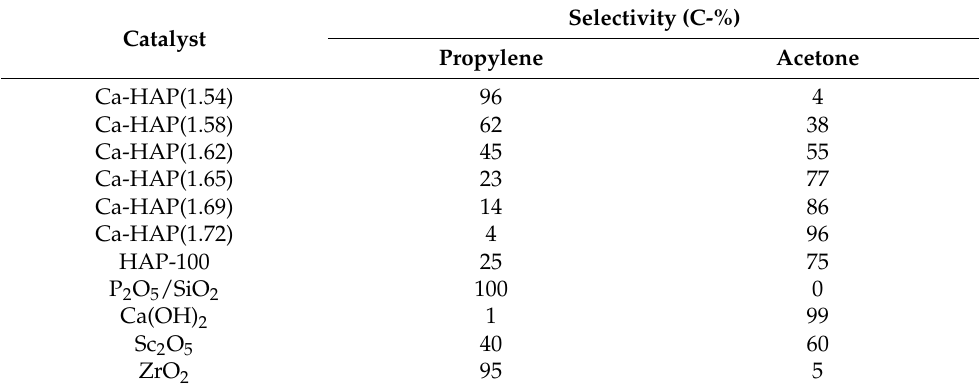
Table 4. Catalytic conversion of 2-propanol into propylene and